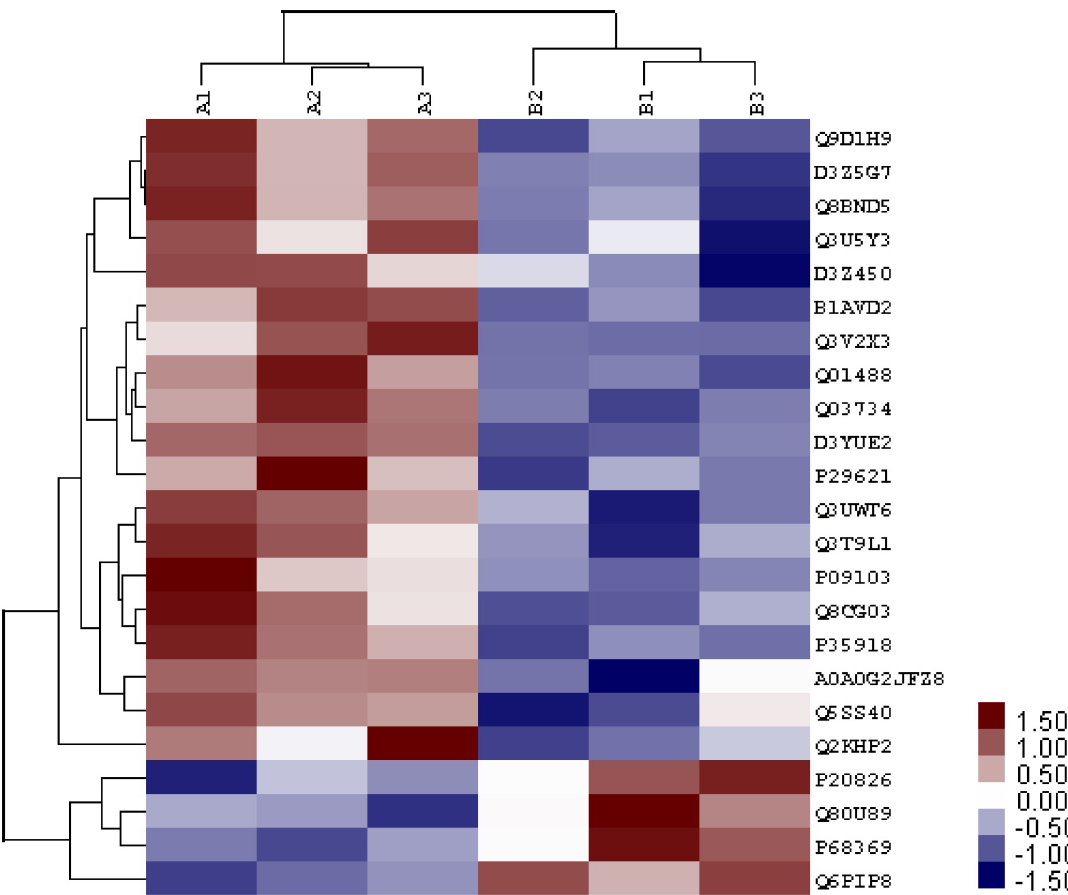
Fig 6. Hierarchical clustering of 23 differentially expressed proteins. Log2 of normalized counts of differential proteins were clustered. Red clusters denote high levels of expression whereas blue clusters denote low levels of expression. The x axis represents the samples whereas the y axis represents the